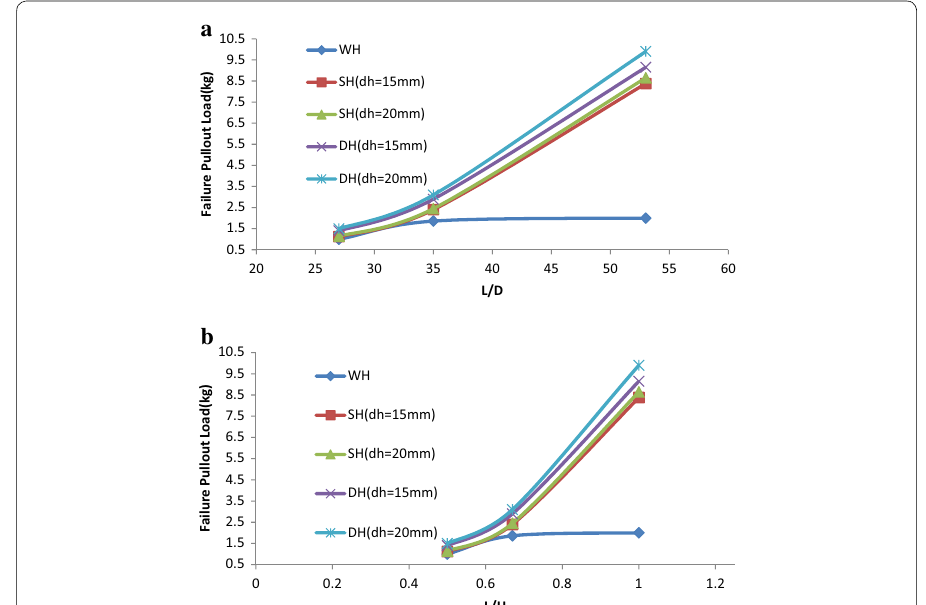
Fig. 21 a Variation of failure pullout load with L/D ratio of helical pile. b Variation of failure pullout load with L/H ratio of helical pile